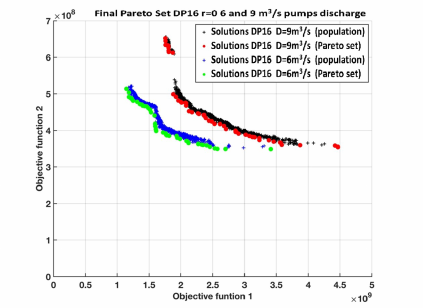
Figure 13. Pareto set for scenario 2 of Table 2.